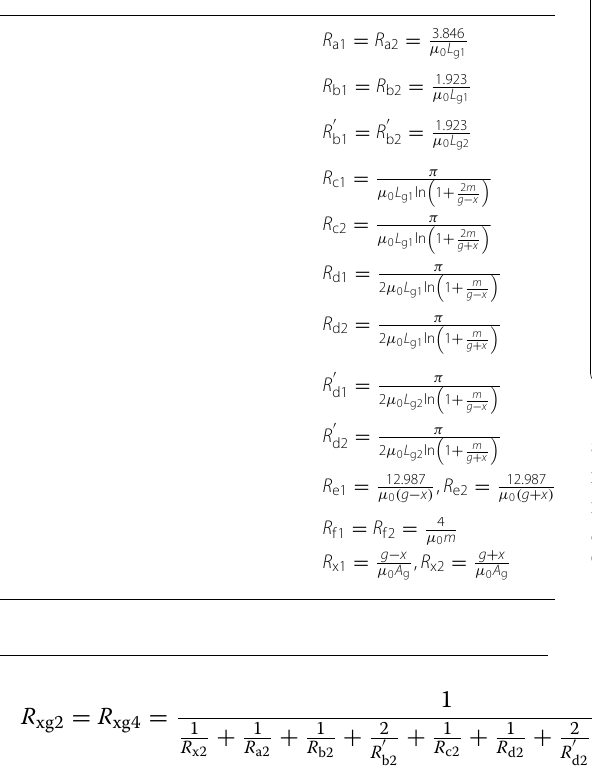
Table 2 Reluctance calculation result Reluctance Result